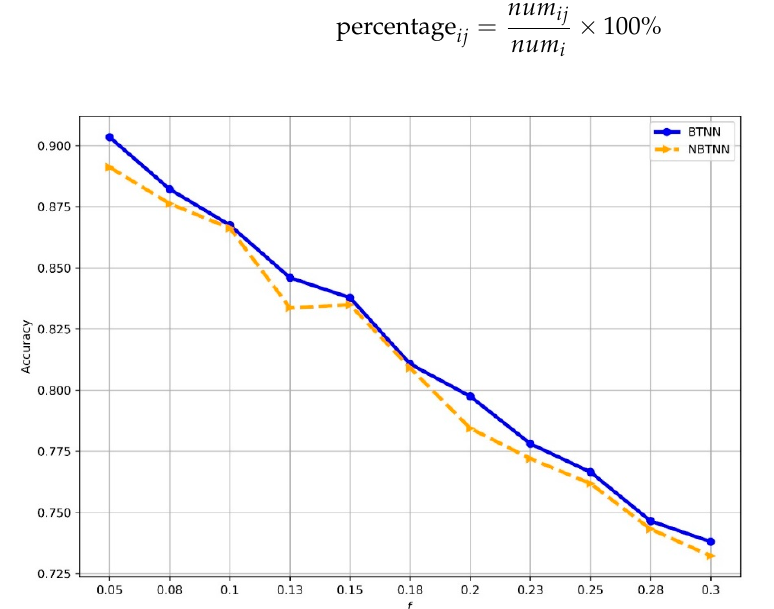
Figure 6. Comparison of the performance under different f between BTNN and NBTNN .